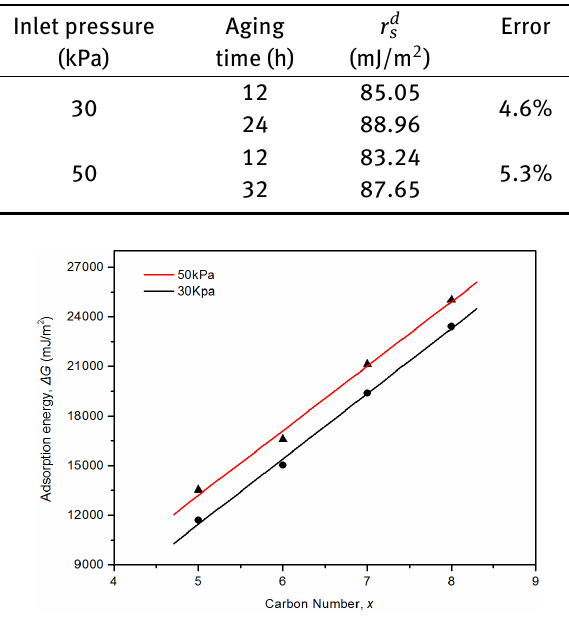
Figure 1: The effect of inlet pressure of column (Sample A)